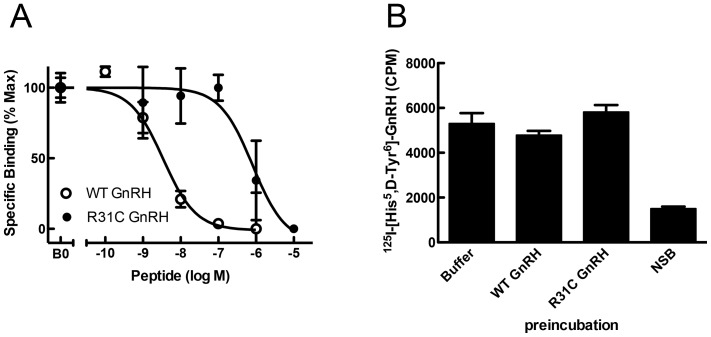
Binding of WT and R31C GnRH to the GnRH receptor (GnRH-R).(A) COS-7 cells were transiently transfected with a human GnRH-R DNA construct and incubated with a 125I-labeled GnRH agonist in the presence of indicated concentrations of WT GnRH or R31C GnRH. IC-50 values are WT GnRH, 2.8×10−9 M and R31C GnRH, 8.50×10−7 M. Data are given as means and SD of two experiments performed in duplicate. (B) Transfected COS-7 cells were pre-incubated with buffer alone, WT GnRH (10−8 M) or R31C GnRH (10−5 M) and then washed to allow dissociation of ligand not covalently attached to the GnRH-R. Pre-incubated cells were then incubated with 125I-labeled GnRH agonist in the absence or presence of saturating concentration of unlabeled WT GnRH (NSB). Data are the means of two experiments performed in triplicate.